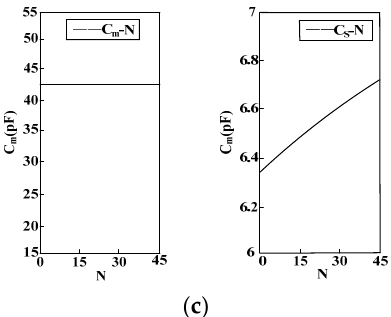
Figure 11. Simulation result of electrode structure optimization. ( a ) Relation curve of equivalent capacitance and electrode radius; ( b ) Relation curve of equivalent capacitance and electrode width; ( c ) Relation curve of equivalent capacitance and number of electrodes.